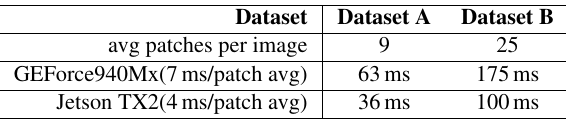
Table 8. Average runtime per